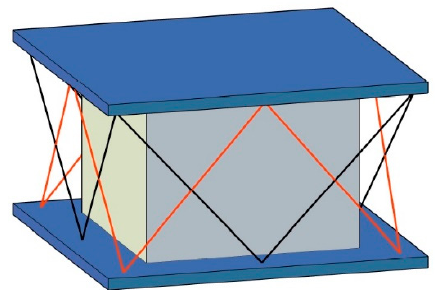
Figure 4. Double cross configuration of SMA-LRB.